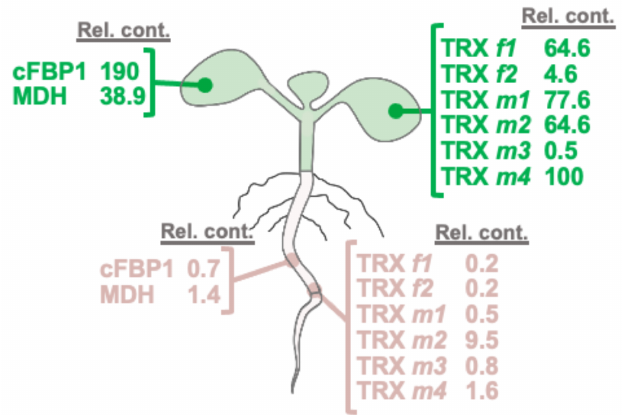
Figure 9. Protein relative content of plastid thioredoxins and their classical targets cFBP1 and MDH in cotyledons and roots of Arabidopsis. Presented values are relative to that of the most abundant TRX in cotyledons (TRX m4 ). Data were obtained from the database “Proteomics DB” (ProteomicsDB: a multi-omics and multi-organism resource for life science research. Available